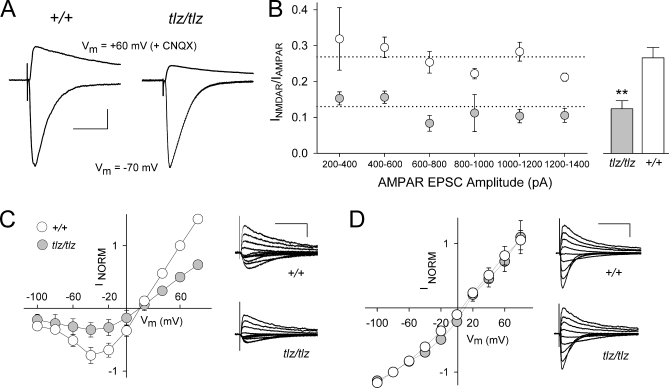
Reduction of Basal NMDAR EPSC Amplitude at Schaffer Collateral-CA1 Synapses of Neto1-Null Mice(A) Representative traces of AMPAR and NMDAR EPSCs from an individual +/+ (left) or tlz/tlz (right) neuron. The bottom trace in each was recorded at a holding potential of −70 mV (V
m = −70 mV) then CNQX (10 μM) was bath applied and the top traces recorded at a holding potential of +60 mV (V
m = +60 mV). Each trace is an average of six consecutive responses. For all traces the intensity of the Schaffer collateral was 10 V. INMDAR/IAMPAR was 0.31 for the +/+ neuron and 0.12 for the tlz/tlz neuron (scale bar: 80 ms, 100 pA).(B) Left: the plot shows INMDAR/IAMPAR as a function of AMPAR EPSC amplitude in +/+ (open circles) and tlz/tlz (filled circles) neurons. The range of synaptic activation was generated by an ascending series of stimulus intensities with the neuron at V
m = −70 mV and then at V
m = +60 mV + CNQX (10 μM) for each neuron tested with INMDAR/IAMPAR calculated for each corresponding stimulus. The data are plotted in 200 pA bins of AMPAR EPSC amplitude. The dotted line shows the overall mean of the INMDAR/IAMPAR for all data points across the amplitude range. Right: For each neuron, the average INMDAR/IAMPAR was calculated and the histogram shows the mean of INMDAR/IAMPAR for tlz/tlz (filled bar) or +/+ (open bar) neurons (**, p < 0.01).(C) Current-voltage (I-V) graph for pharmacologically isolated NMDARs from +/+ (open circles) and tlz/tlz (filled circles) mice. Right: superimposed NMDAR EPSC traces at V
m from −100 to +80 mV in steps of 20 mV (scale bars: 150 ms/ 125 pA).(D) Current-voltage (I-V) graph for AMPAR EPSCs from Neto1+/+ (open circles) and Neto1-null mice (filled circles). Right: superimposed AMPAR EPSC traces (scale bars: 200 ms/ 200 pA). Error bars show ± standard error of the mean (SEM).